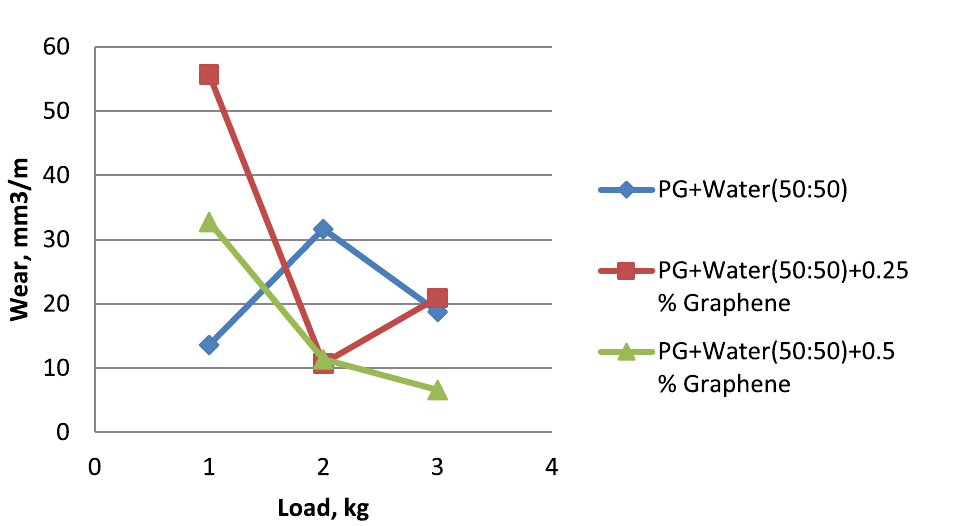
Figure 5. Load vs. wear rate for propylene glycol (75:25).